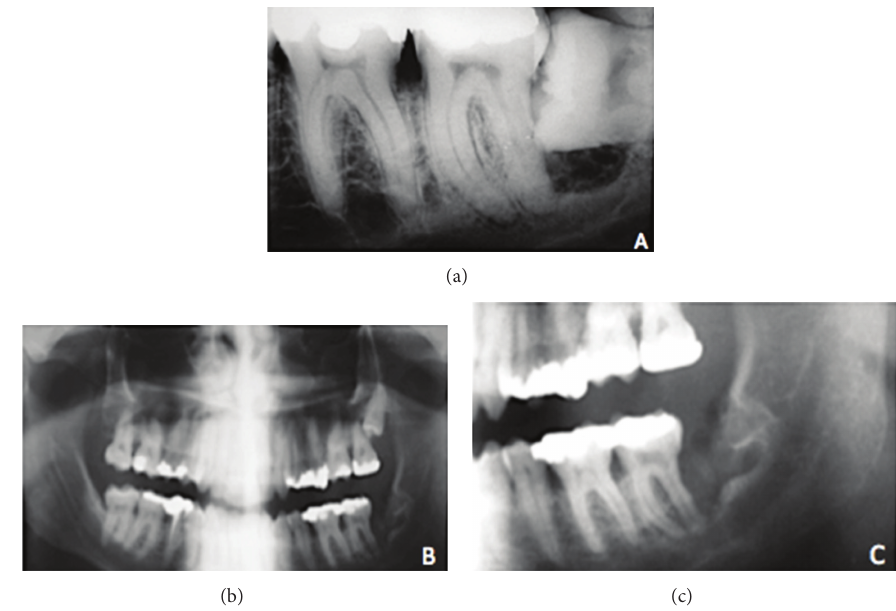
Figure 1: (a) Periapical X-ray showing a radiolucency surrounding the crown of the left third molar suggestive of dentigerous cyst. (b-c) Panoramic X-ray performed after 15 days of the third molar extraction showing no suggestive malignant transformation.